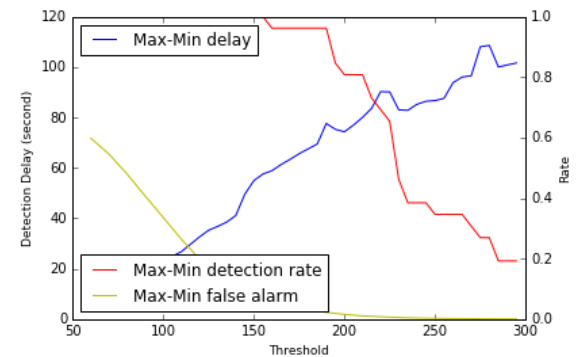
Figure 23. Detection example of max-min detector on PUE